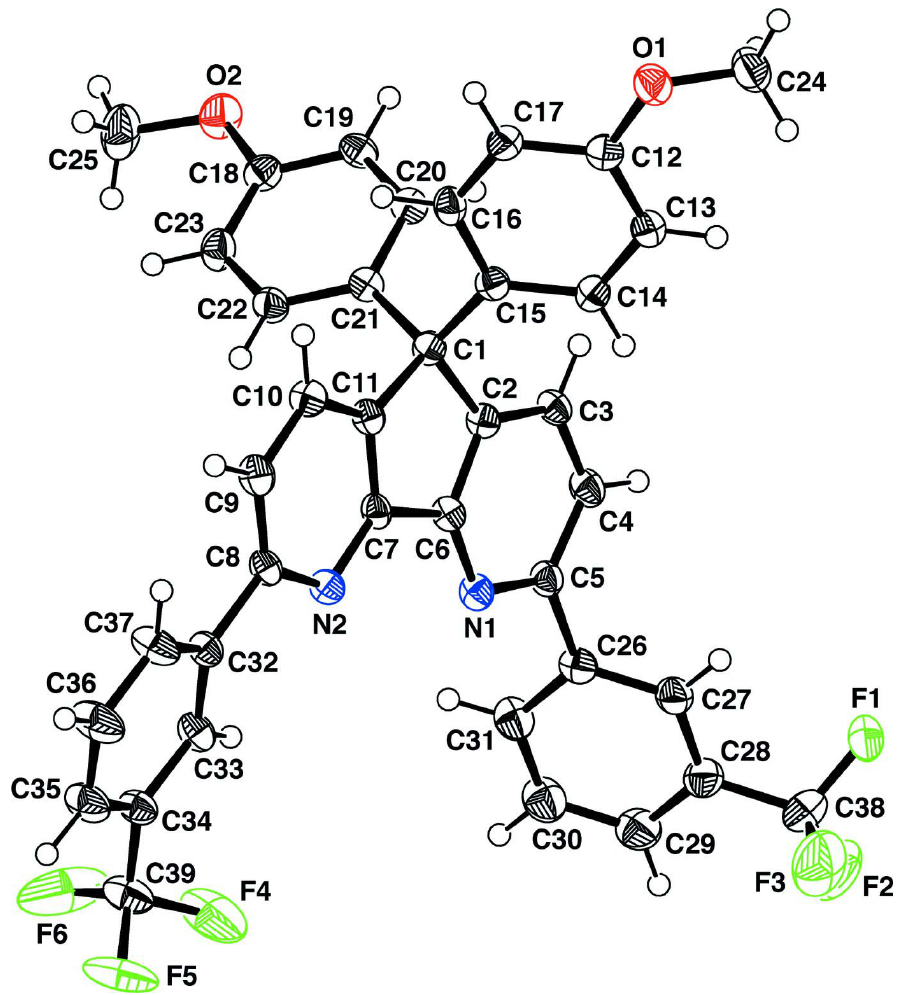
Figure 2 The molecular structure of (I), with 50% probability displacement elipsoids for non-H atoms and H atoms are shown as small spheres of arbitrary radius. The disordered fluorine atoms (F7–F12) of the two trifluoromethyl groups are omitted for